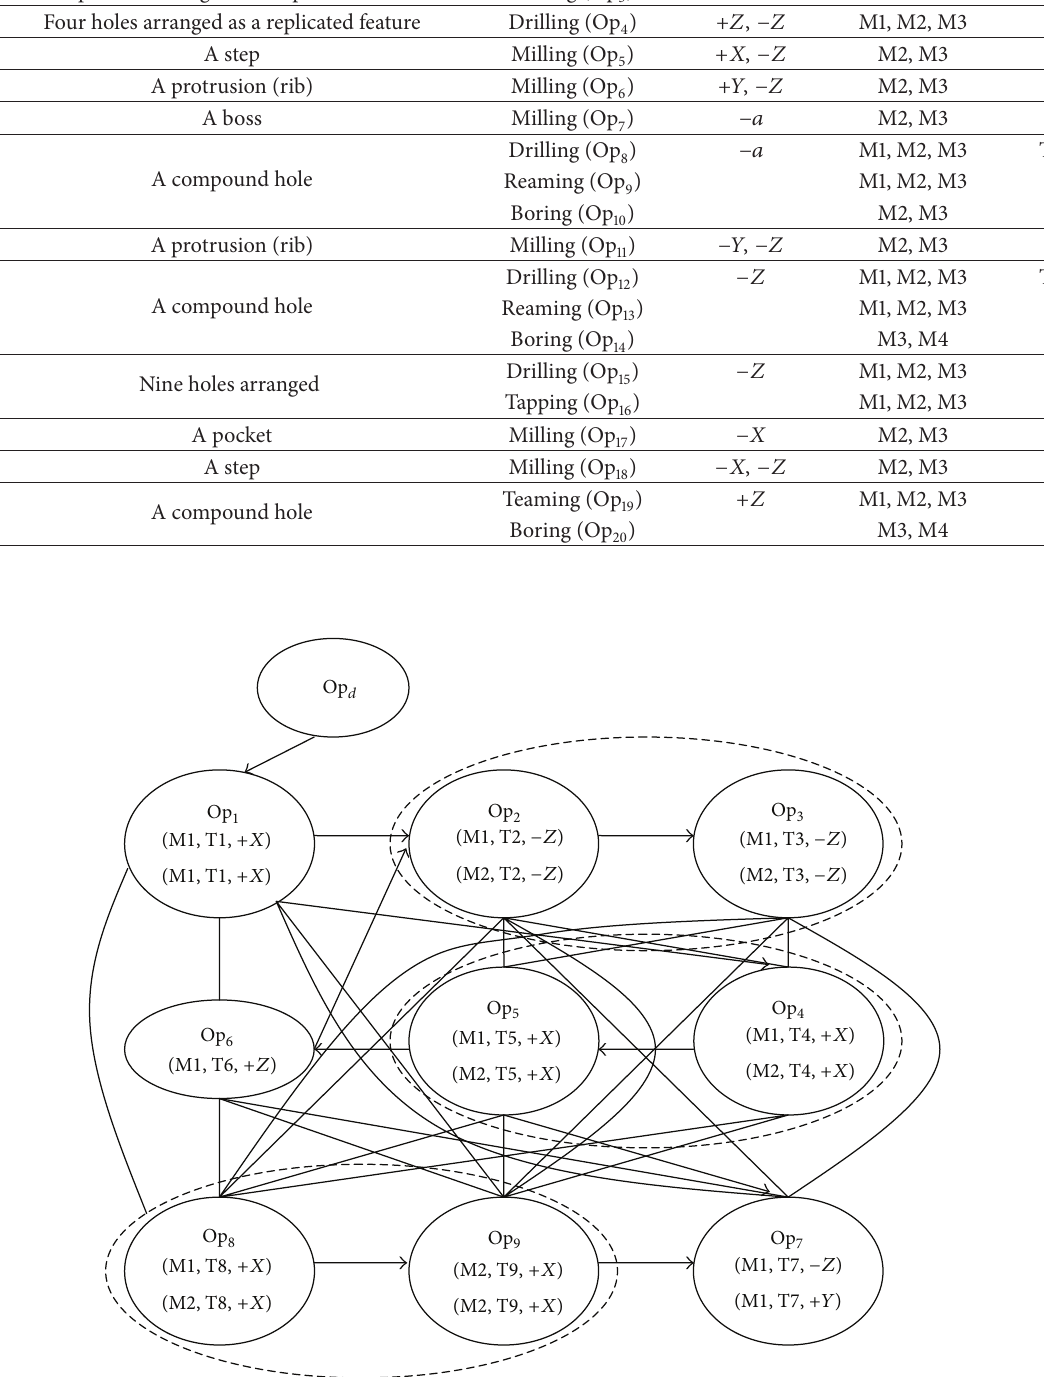
Figure 3: A disjunctive weighted directed graph for the example